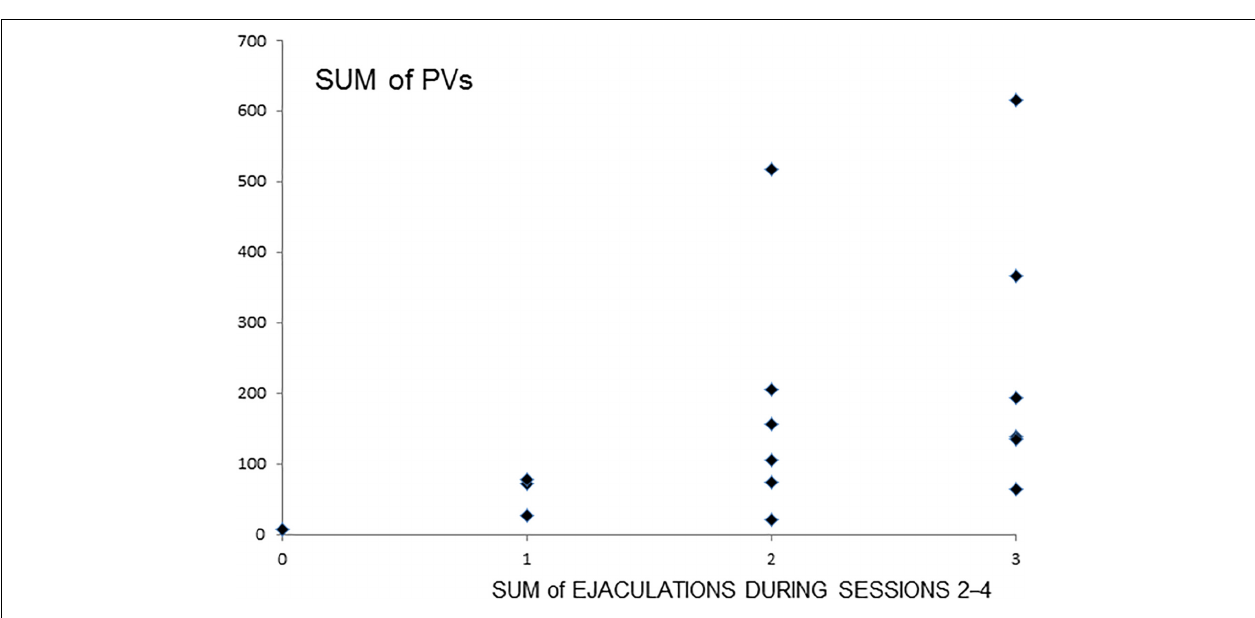
FIGURE 2 | Total number of PVs with relation to the sum of ejaculations during sessions 2–4. Numbers on the X-axis represent the sum of ejaculation from 0 to 3 achieved by the male during all three sessions 2–4. 0- means that male did not achieve any ejaculation during three sessions, respectively, 1—only one ejaculation during three sessions, 2—two ejaculations, and 3—ejaculated in each session. Numbers on the Y-axis represent the sum of PVs emitted by the male during sessions 2–4. The diamond represents an individual male. r = 0.5608, P <